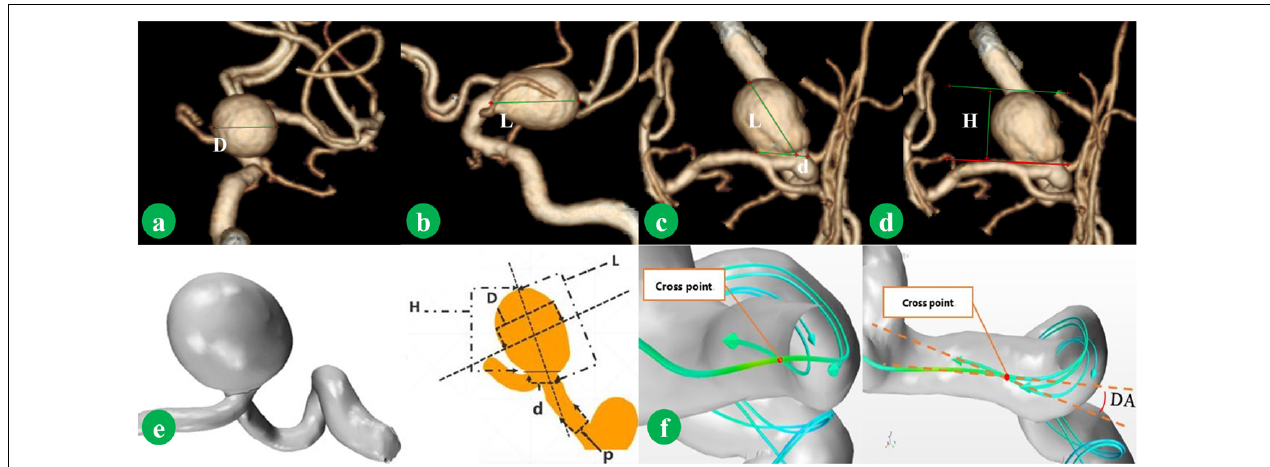
FIGURE 1 | Morphological parameters were measured from CTA image. D is the maximum diameter of the body (a) . L is the maximum distance of the dome from the neck plane (b) . d is the average diameter of the neck (c) . H is the maximum perpendicular distance of the dome from the neck plane (d) . The method of measurement is shown in (e) . p is average diameter of the parent artery. Normal vector was combined. The deviated angle (DA), which was between co-velocity and normal vector, was measured (f)